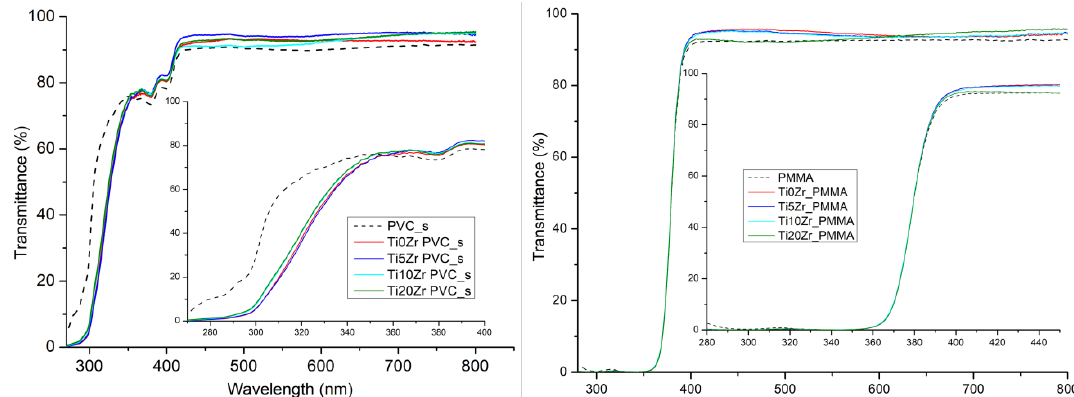
Figure 3. UV-Vis transmittance spectra for polyvinyl chloride (PVC_s) ( left ) and polymethyl methacrylate (PMMA) ( right ) samples.